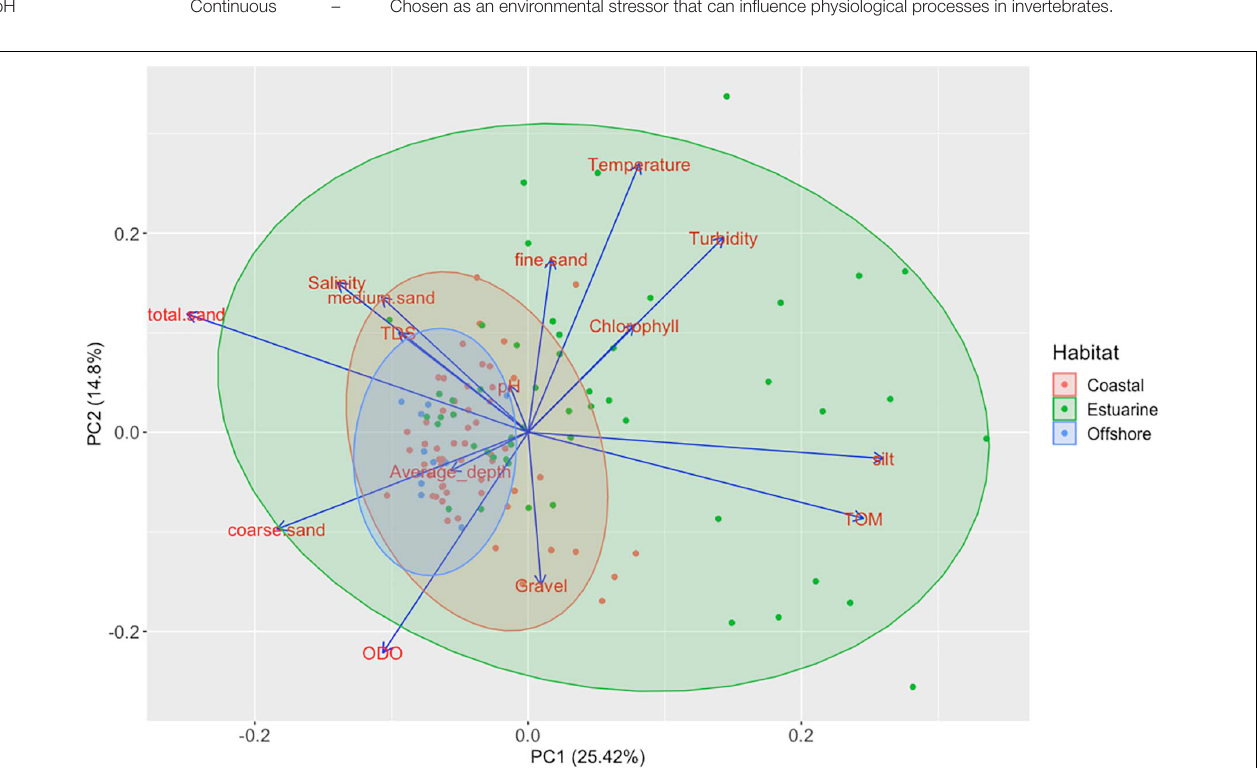
FIGURE 2 | Principal Component Analysis (PCA) diagram of environmental data by sampled site, grouped according to habitat, classified as coast, estuary, and offshore.